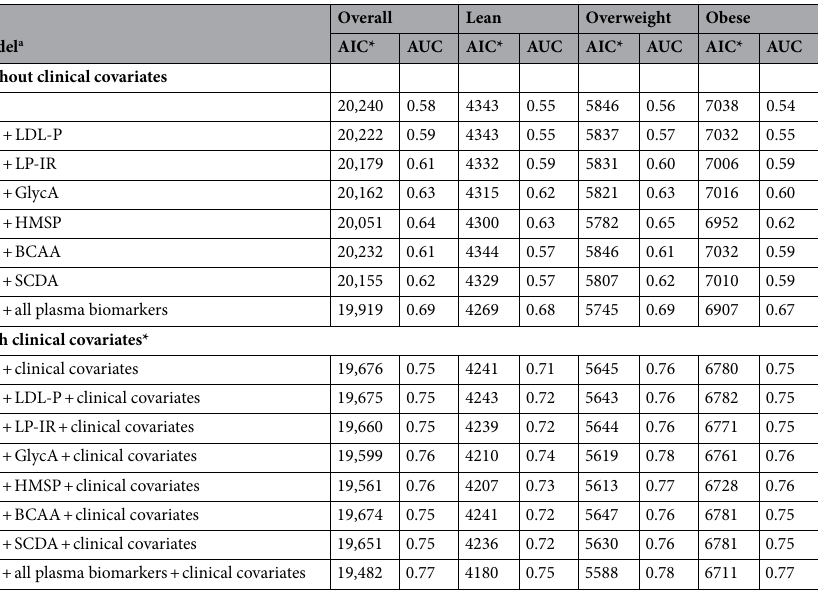
Table 3. Comparison of model fit characteristics overall and stratified by BMI category. *AIC analyses were restricted to individuals who had data needed for all models of traditionally defined MH and for all biomarkers (n = 3222). Clinical covariates include: age, sex, race, LVEF, CAD, family history of CAD, smoking, LDL-C, and